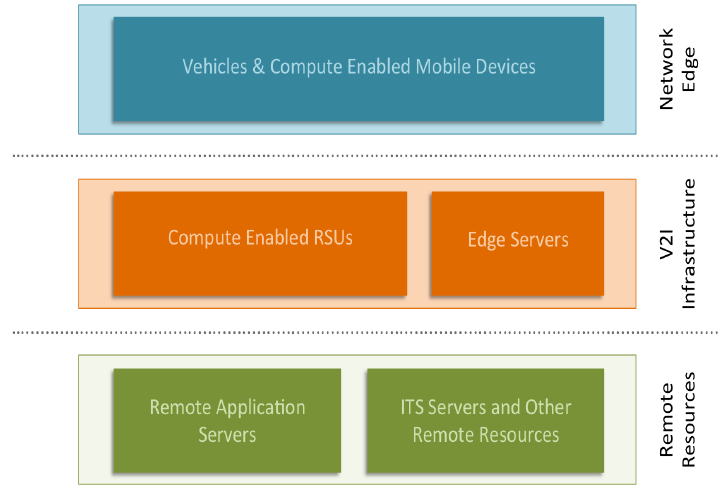
Figure 1. Contextual architecture for mobile edge-computing in vehicular networks (CAMEVAN)